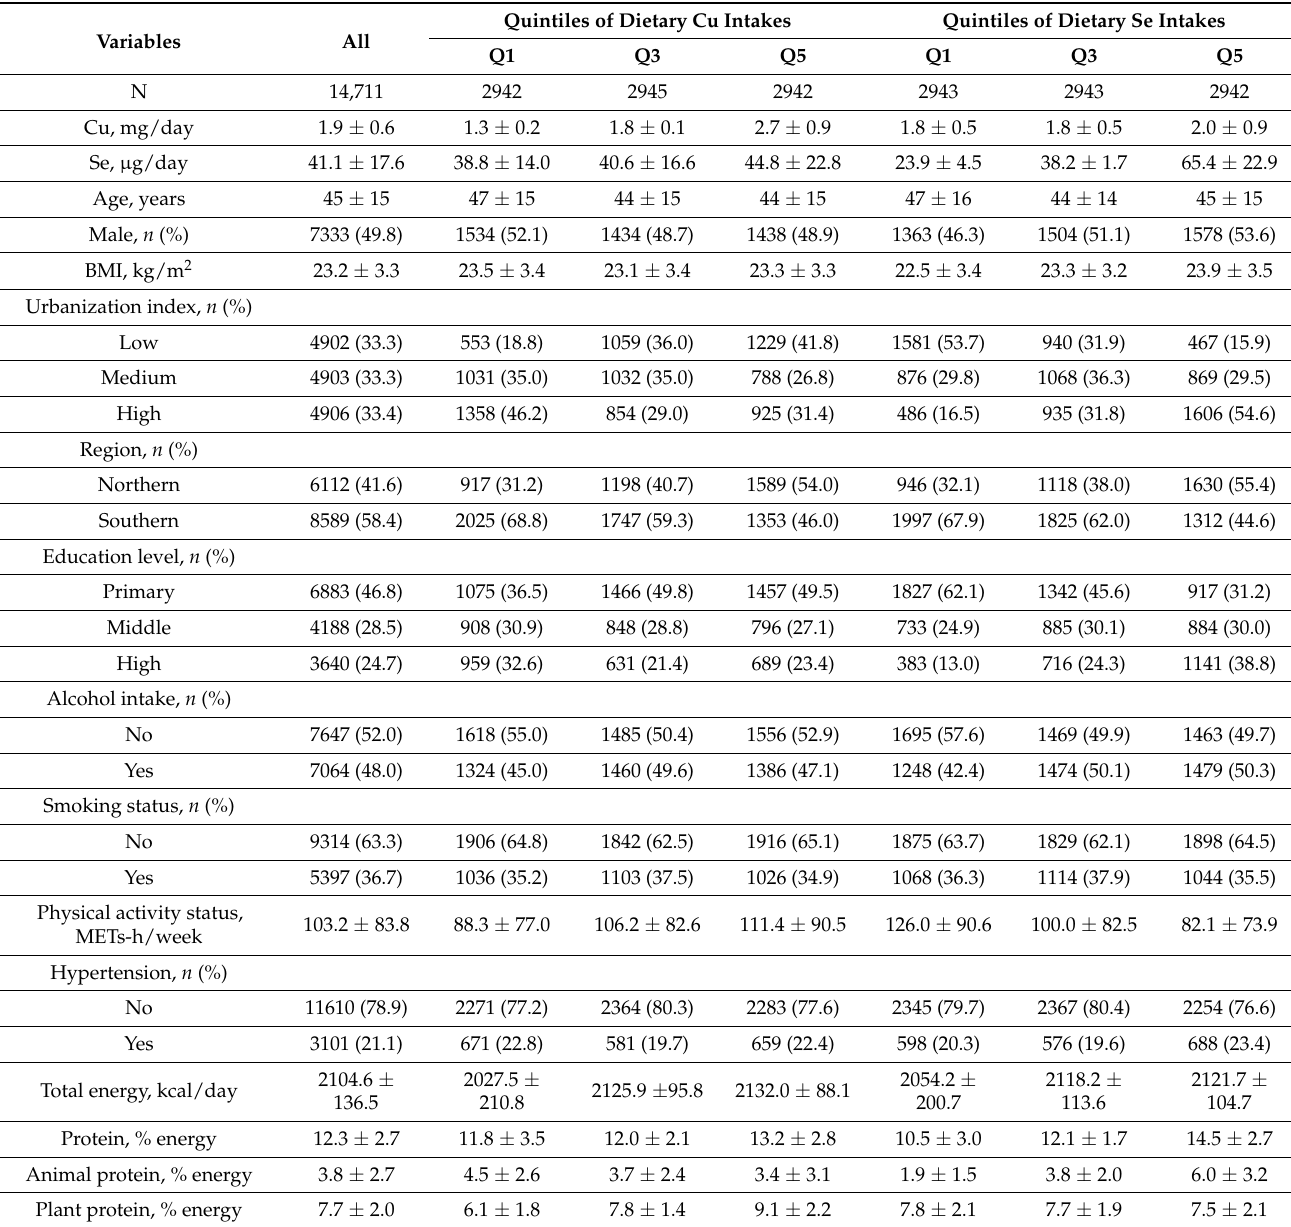
Table 1. Baseline characteristics of 14,711 Chinese adults in the China Health and Nutrition Survey, 1997–2015, according to quintiles of dietary Cu and Se intakes 1